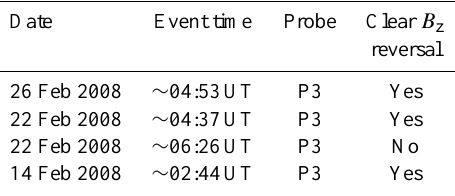
Table 1. Four THEMIS dipolarization events that have been inves- tigated and which show similar features. From all four events, only the 3rd one does not show a clear ( − / + ) B z polarity